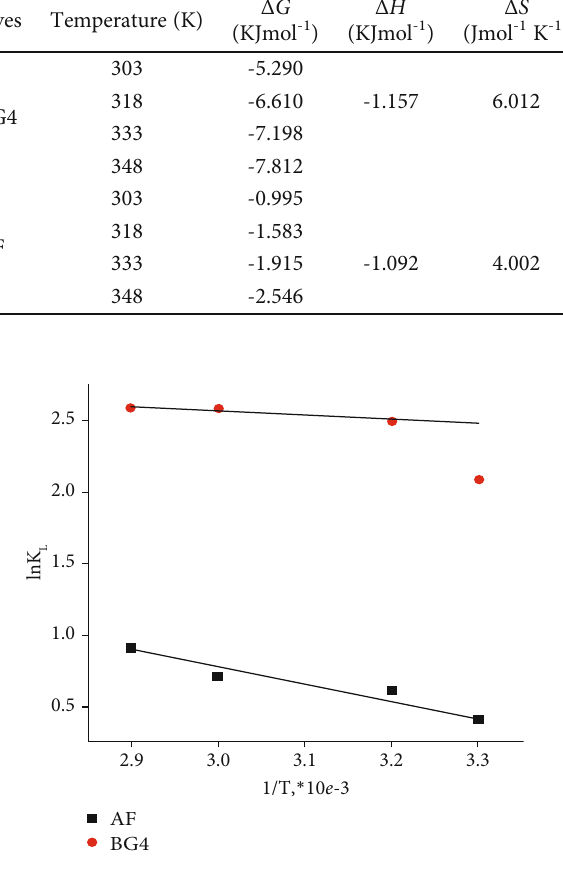
Figure 16: Van ’ t Ho ff plot model for BG4 and AF adsorption onto